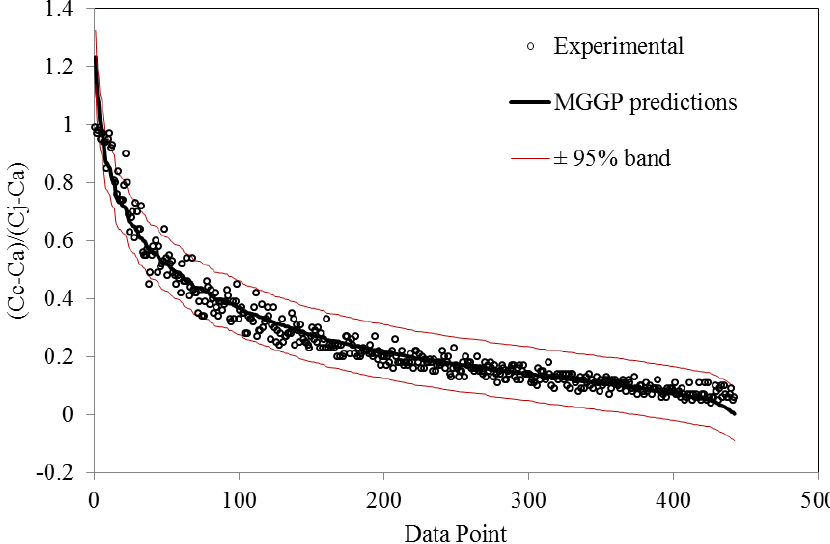
Figure 10. Prediction confidence analysis of the best MGGP model.